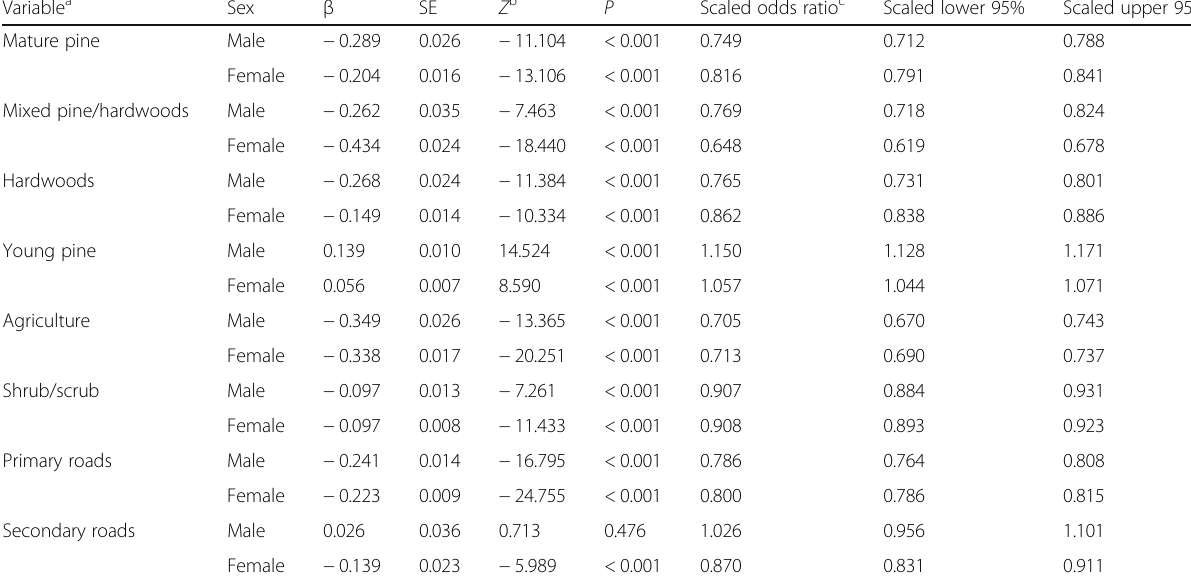
Table 2 Parameter estimates for bobcat habitat selection at the landscape spatial scale Variable